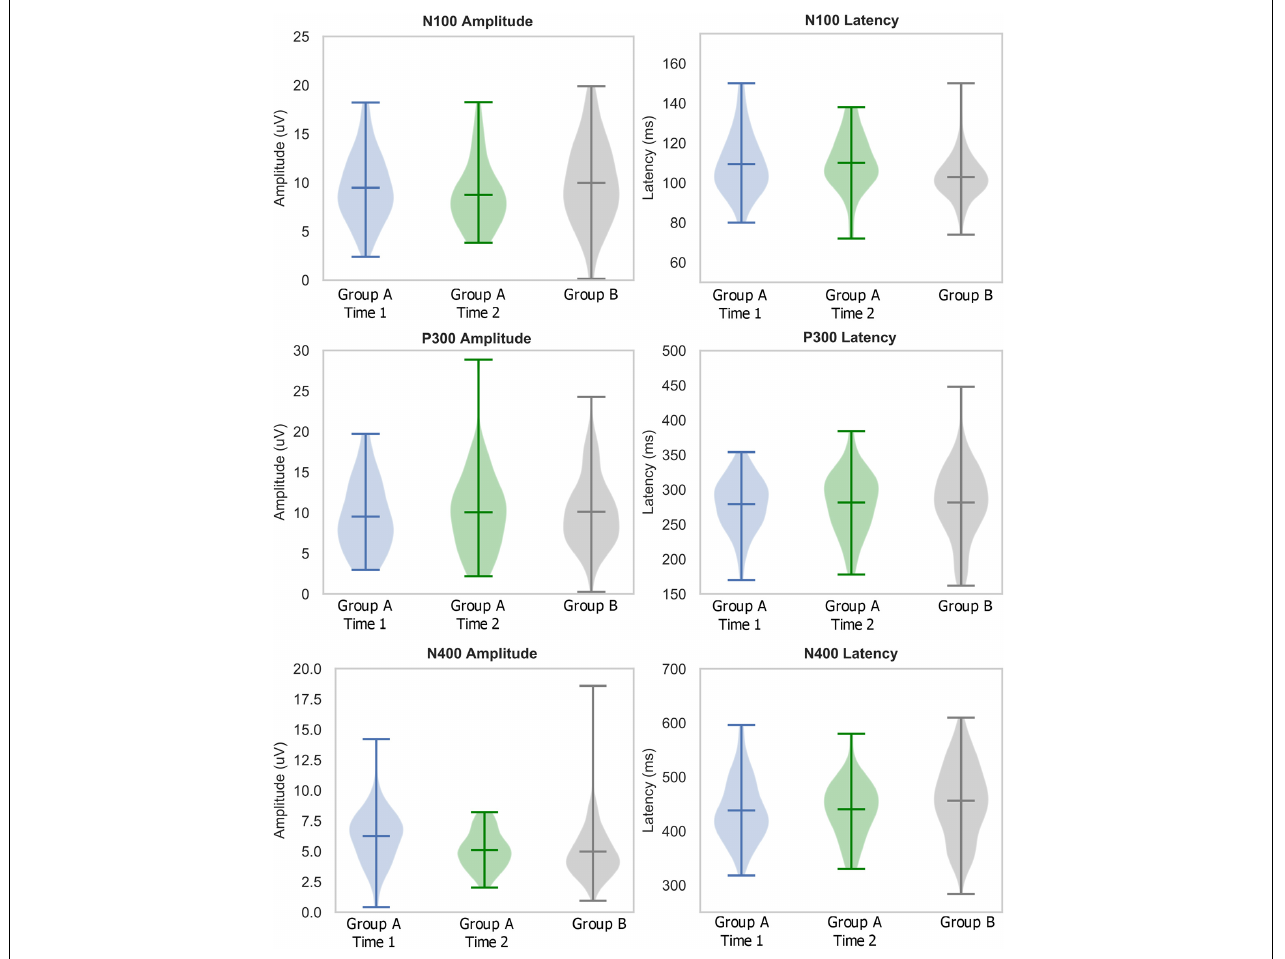
FIGURE 1 | Descriptive statistics: Violin plots describing distributions of relative amplitudes (left) and latencies (right) for N100 (top), P300 (middle), and N400 (bottom) in elite youth ice hockey athletes (Day 1 in blue, Day 2 in green, Ref in Gray). Hashes on the violin plots represent the mean, maximum, and minimum values in the range, with the population probability density shaded. Note: the large ranges in Group A-Time 2 P300 amplitude and Group B N400 amplitude are due to outliers which are included in the violin